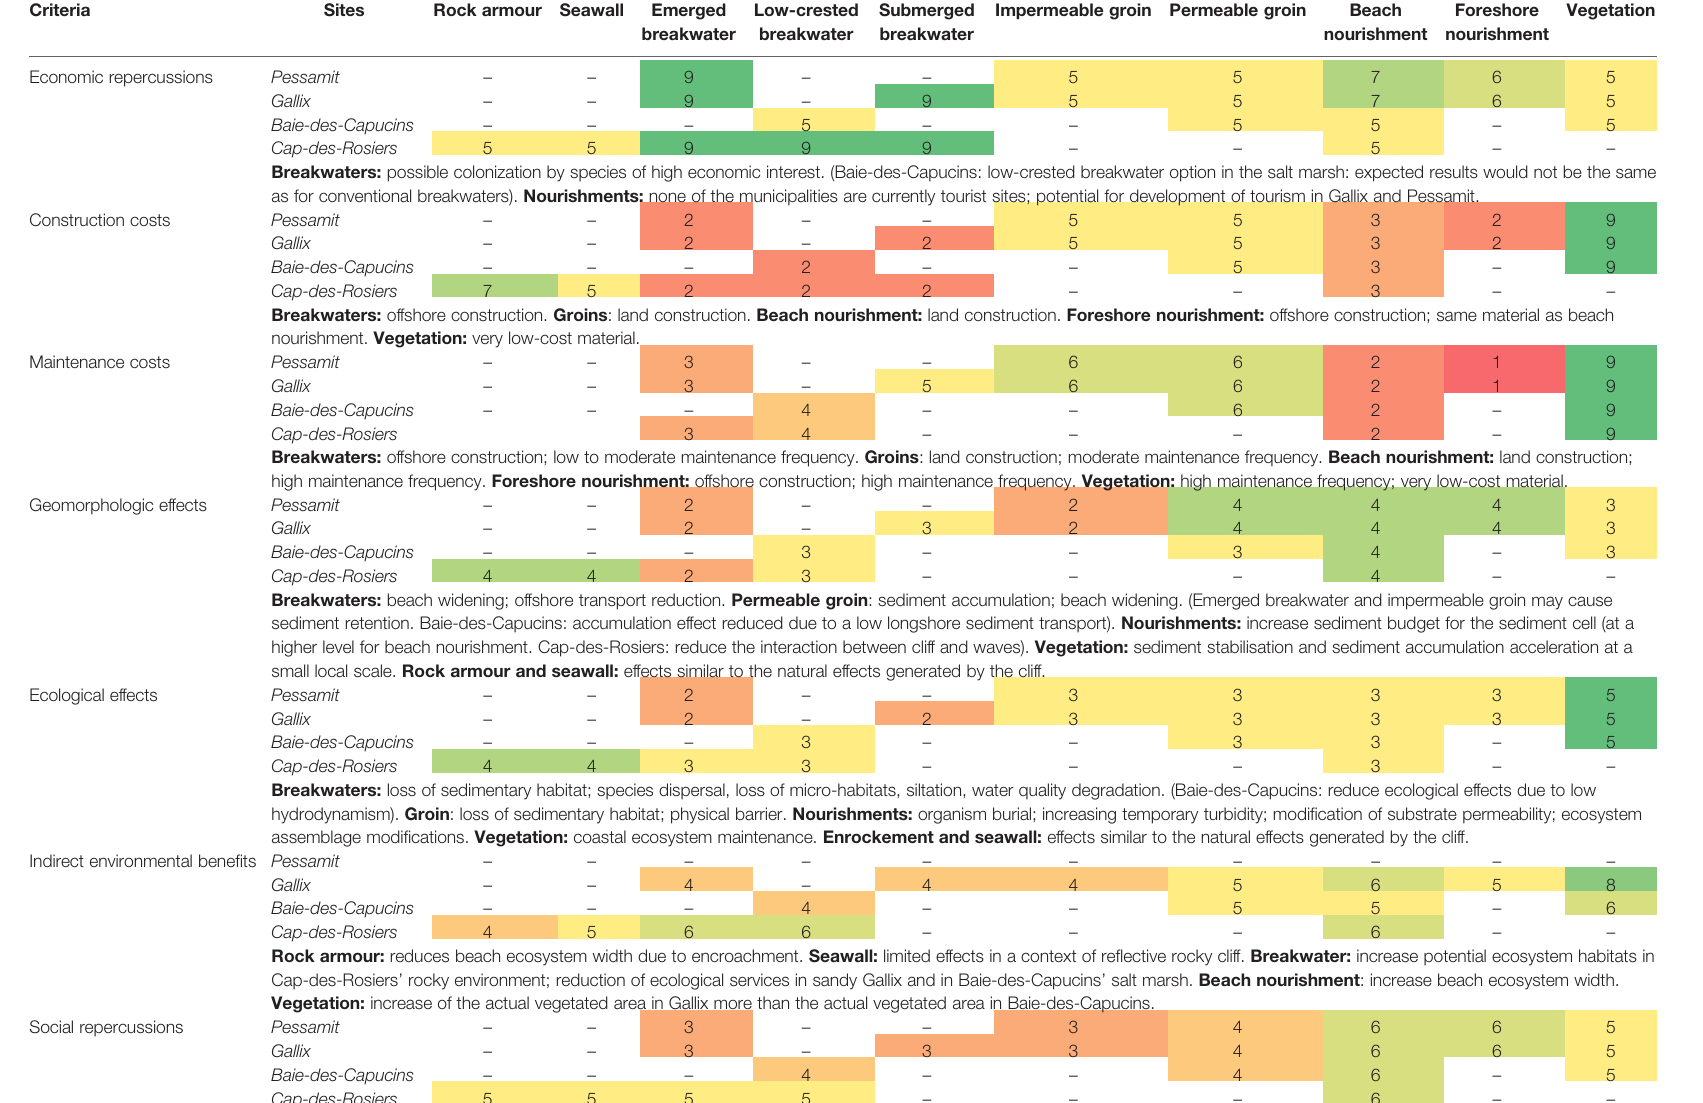
TABLE 6 | Weighting of CDMs in relation to each criterion and sites ’ characteristics, with relevant rationale.